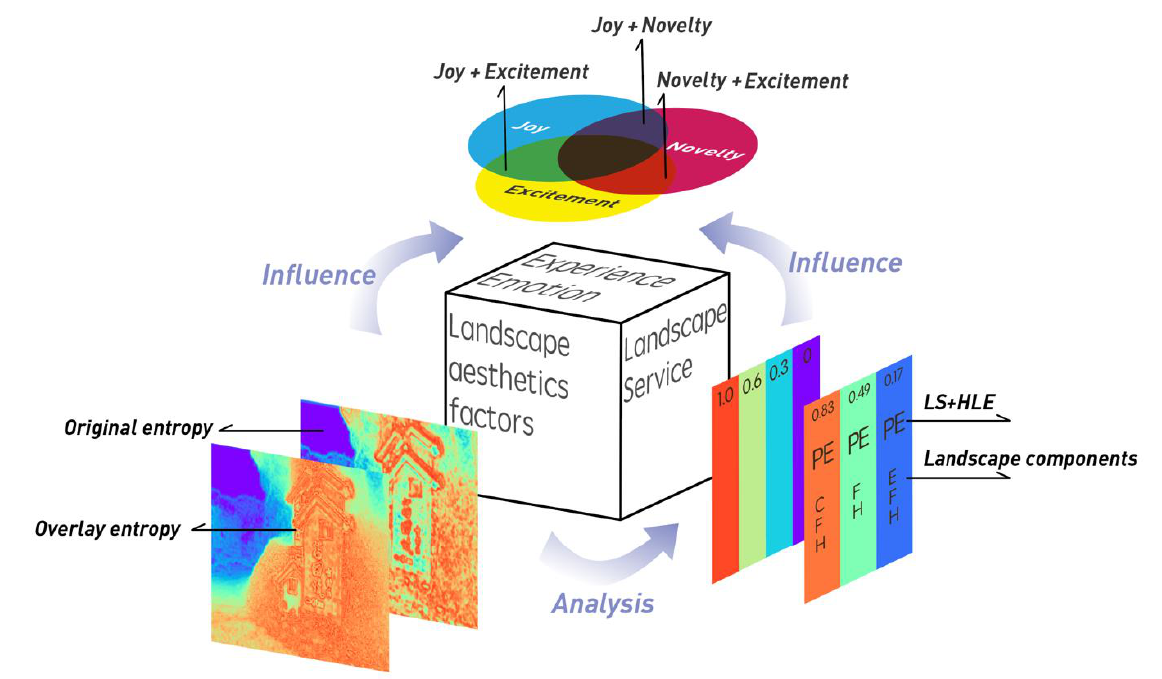
Figure 7. Visualisation framework cube.